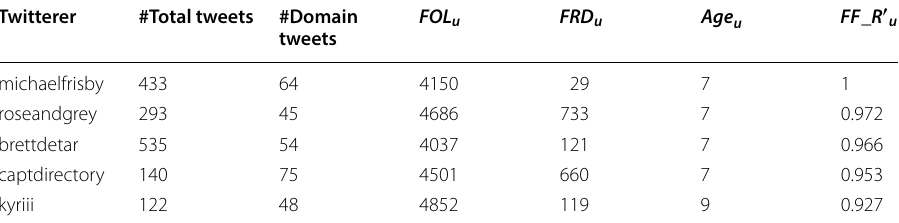
Table 11 Twitter followers—friends ratio, and #tweets in technology and computing